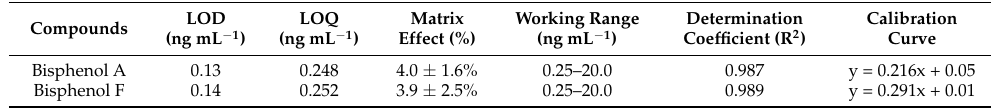
Table 3. Parameters obtained for the calibration curves for BPA and BPF.